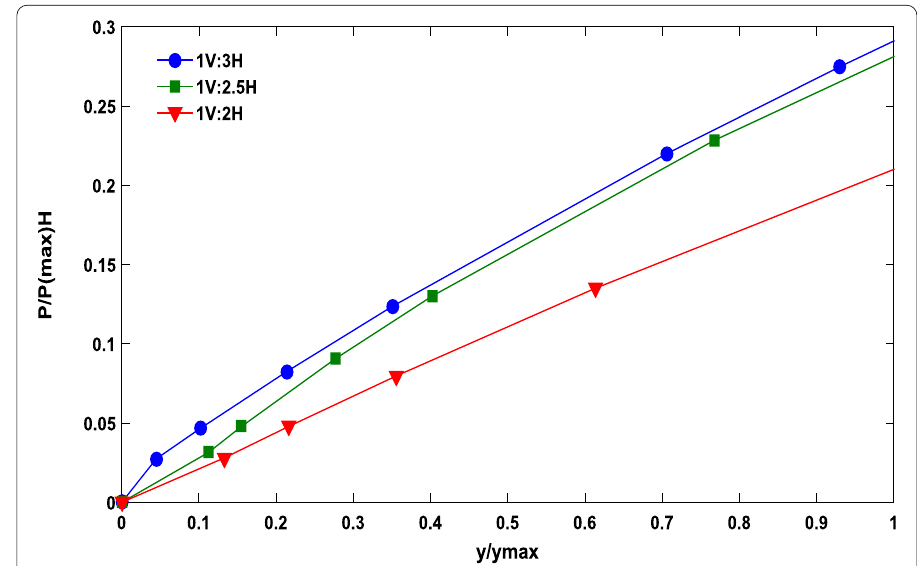
Fig. 14 Lateral load carrying capacity of pile between different slopes under reverse loading